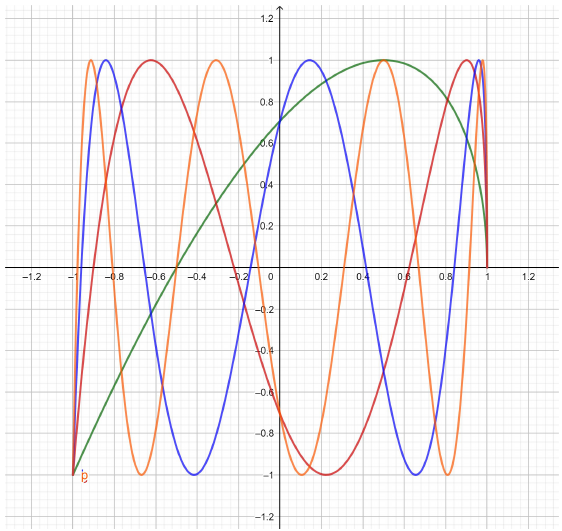
Figure 2. Pseudo U k + 1/2 , k = 1,2,3,4,5. 1, green; 2, red; 3, blue; 4, orange.